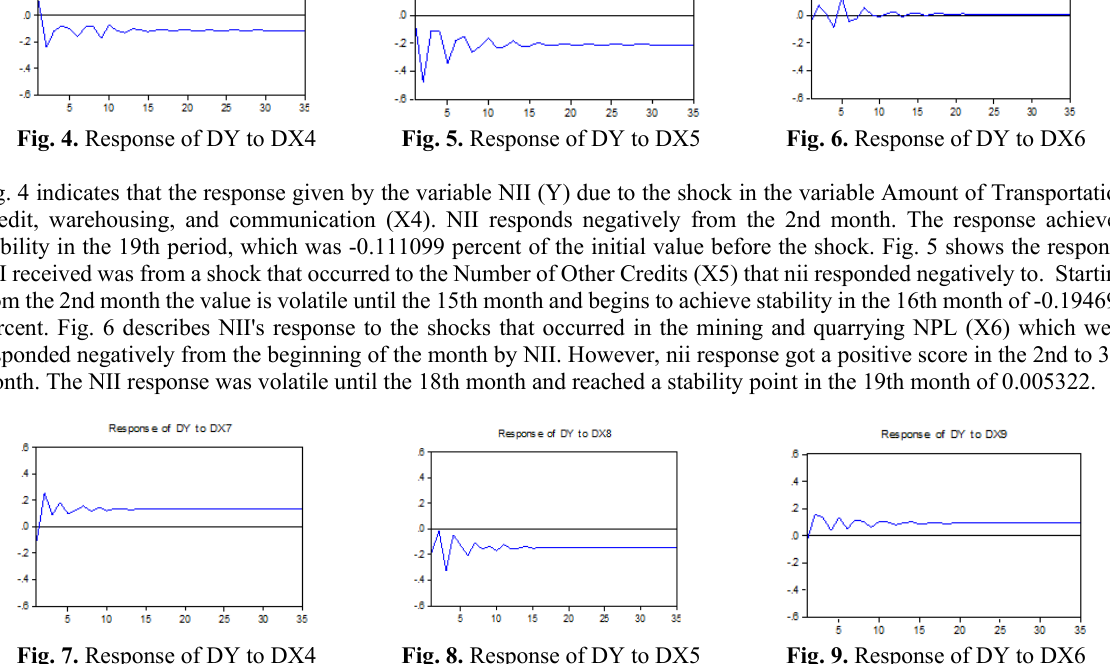
Fig. 7. Response of DY to DX4 Fig. 8. Response of DY to DX5 Fig. 9. Response of DY to DX6